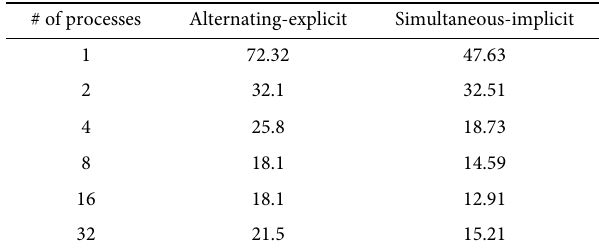
Table 1 Comparison of execution time (seconds) on a 20-second dynamic simulation in GridPACK [32] .